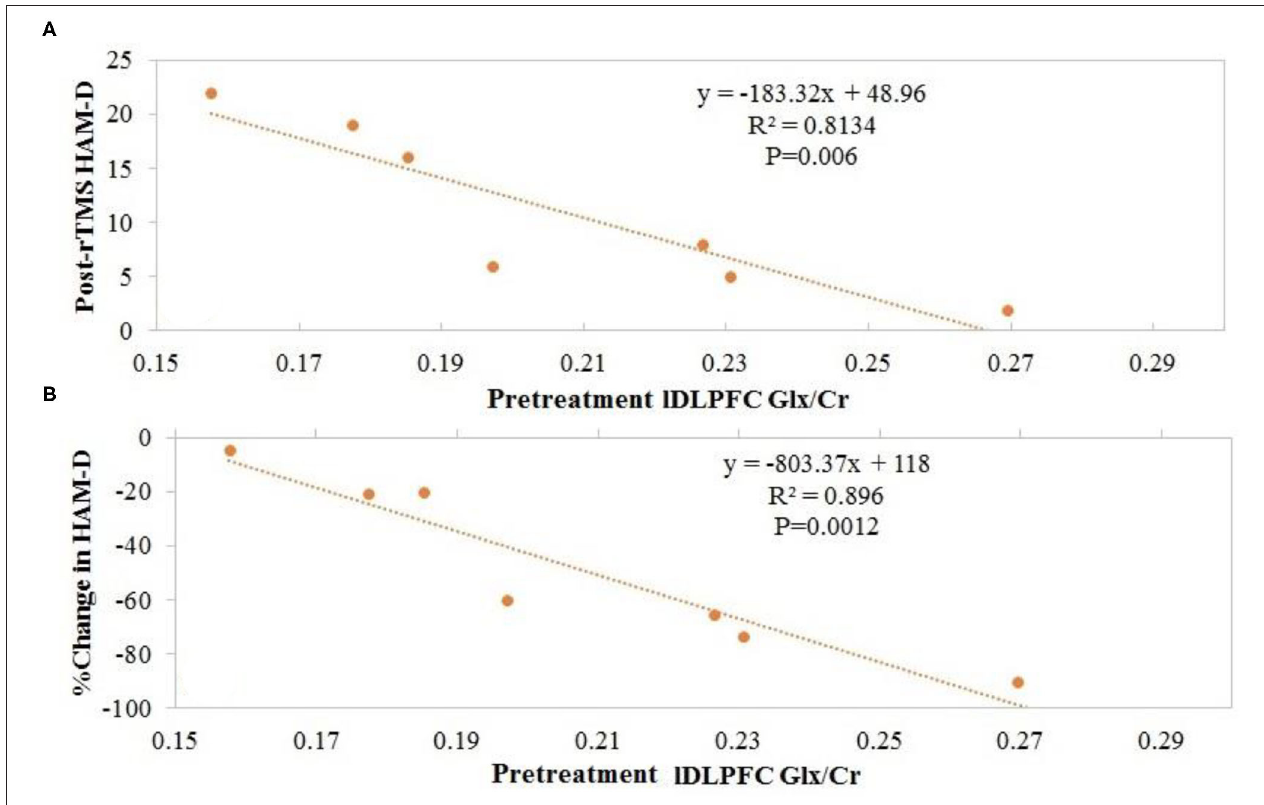
FIGURE 2 | Patients with higher pretreatment glutamate + glutamine (Glx)/total creatine (tCr) at the left dorsolateral prefrontal cortex (lDLPFC) demonstrated (A) lower posttreatment Hamilton Depression Rating Scale (HAM-D) scores and (B) greater change in HAM-D scores after repetitive transcranial magnetic stimulation (rTMS).